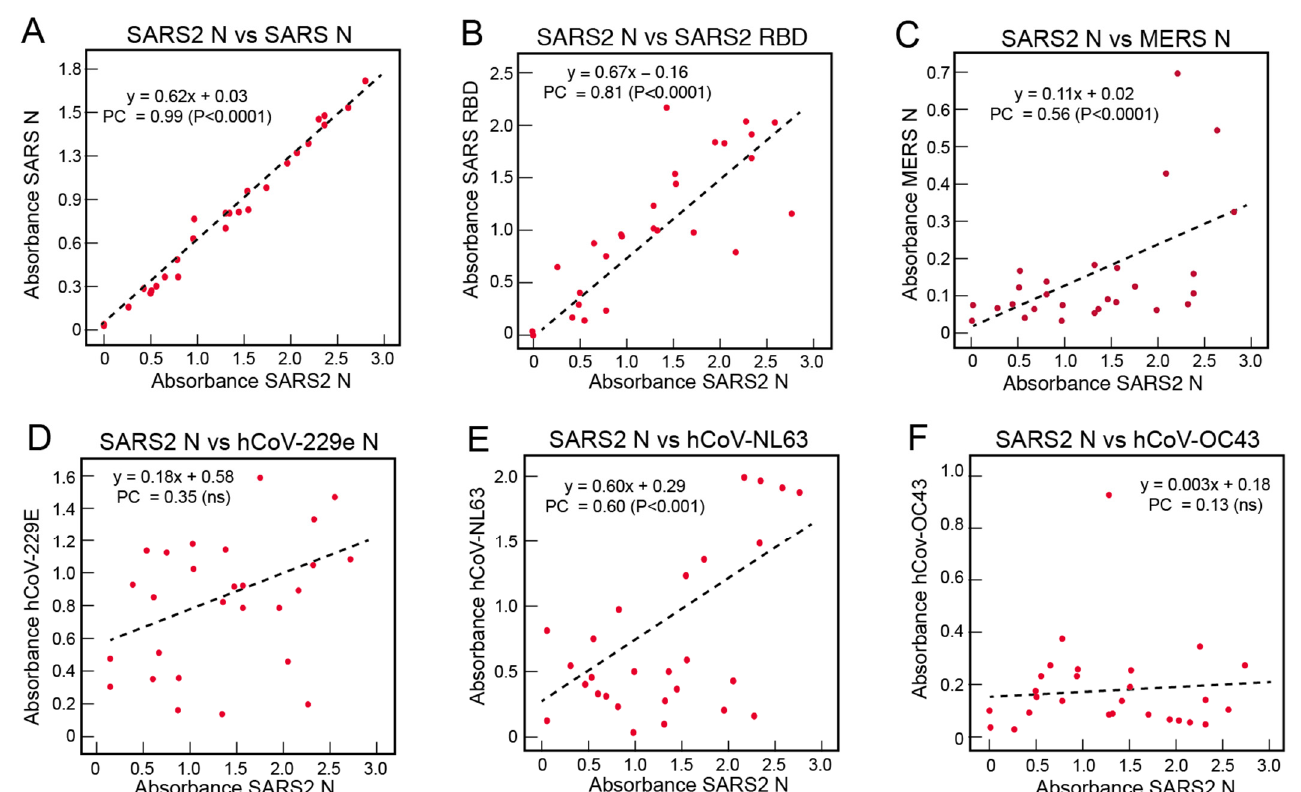
Figure 4. Correlations of the serological responses of COVID-19 subjects to coronavirus antigens. Binding of IgG in serum or plasma samples (1:100 dilution) from COVID-19 subjects was quantified using ELISA coated with recombinant coronavirus proteins. Reactivity to SARS-CoV-2 N was compared to other coronavirus proteins in each panel: ( A ) SARS-CoV N, ( B ) SARS-CoV-2 RBD, ( C ) MERS-CoV-N, ( D ) hCoV-229E N, ( E ) hCoV-NL63 N, and ( F ) hCoV-OC43 N. Dotted lines are linear regression plots of seroreactivity of SARS-CoV-2 N versus other recombinant coronavirus proteins. PC = Pearson’s correlation.